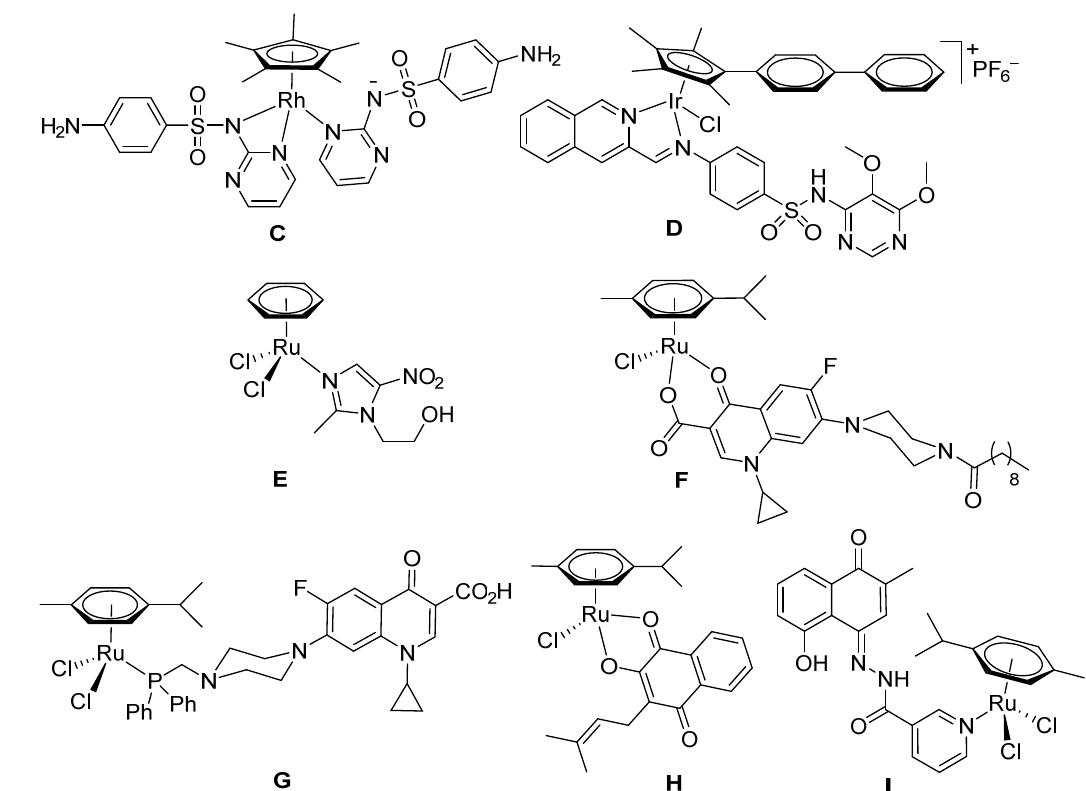
Figure 2. Structure of half-sandwich RhCp* sulfadiazine complex ( C ), IrCp*biph sulfadoxine conjugate D , ruthenium(II)– arene conjugates with metronidazole ( E ), ciprofloxacin ( F and G ), lapachol ( H ), and plumbagin ( I ).